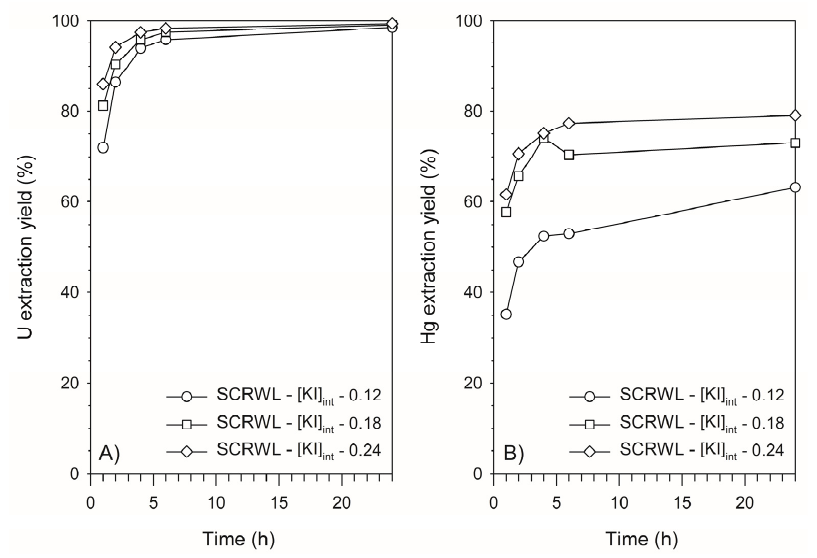
Figure 3. Extraction kinetics of ( A ) uranium and ( B ) mercury on chelating resin Lewatit TP260 (m resin = 3 g; V SCRWL = 100 mL; Speed = 180 rpm).